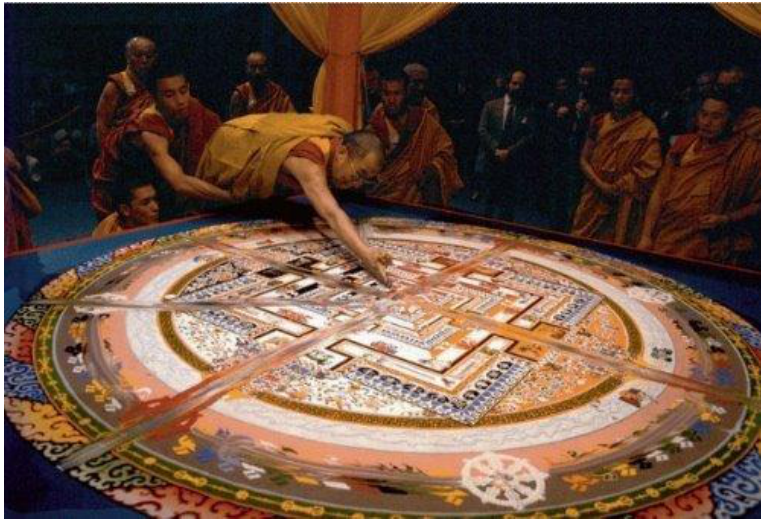
Fig. 2: Dalai Lama ritually disassembling mandala. Photograph by Don Farber. Reproduced with